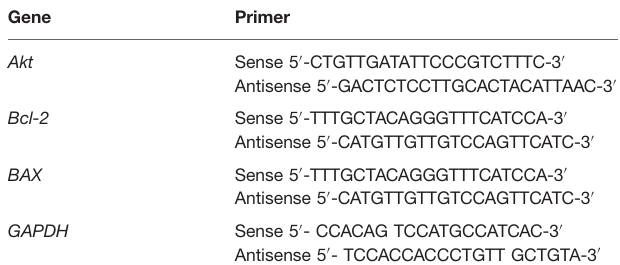
TABLE 1 | Primer sequence for qRT-PCR. Gene